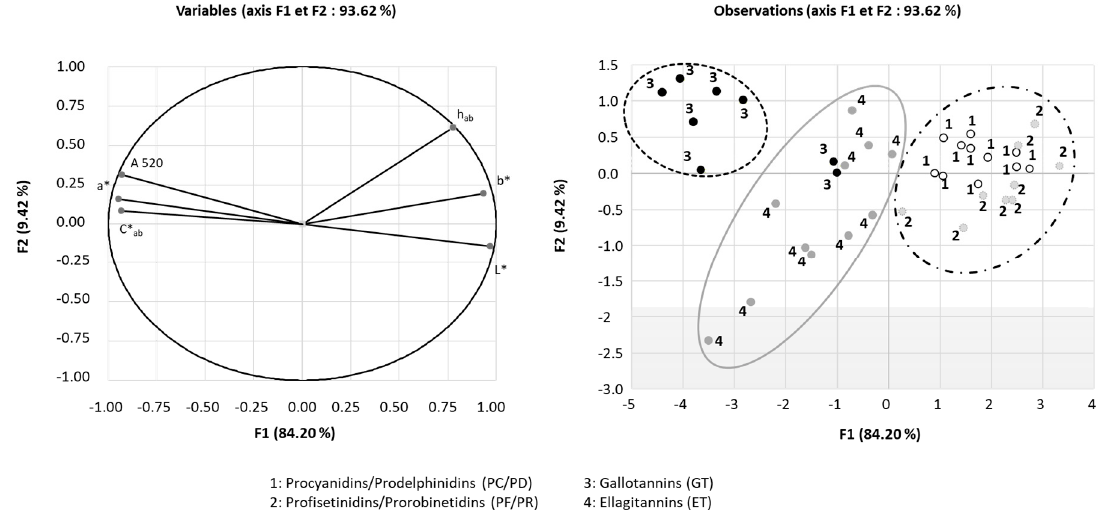
Figure 3. Plot of principal components analysis of model wine solutions of malvidin-3- O -glucoside (50 mg / L) supplemented by increasing concentrations of ( − )-epicatechin and oenological tannins after one week of